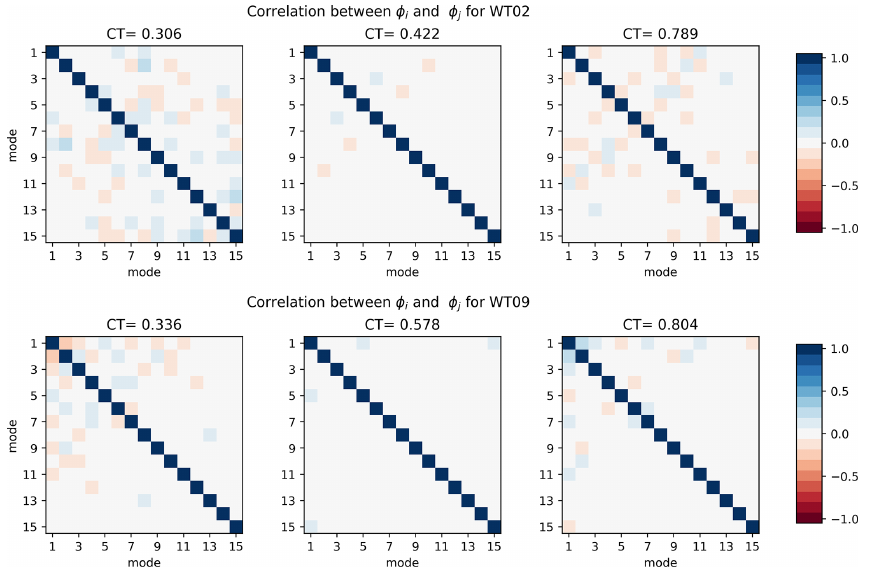
Figure 8. Correlation of the modal time series of first 15 global POD modes for the three C T values for WT02 and WT09.